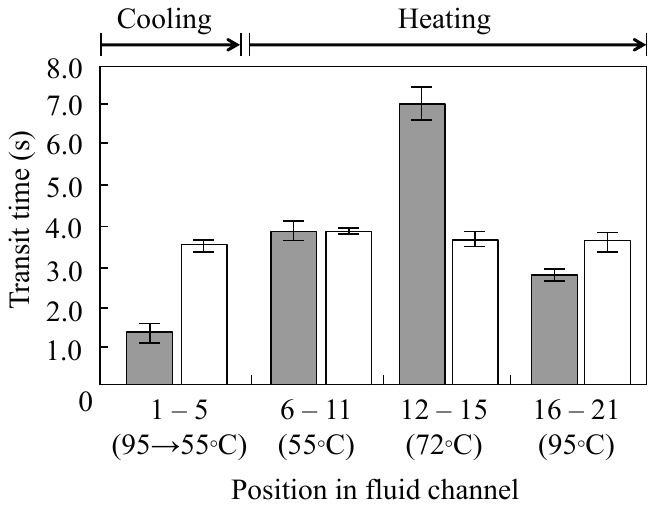
Figure 5. Transit time in each temperature zone. Thermal cycle was performed in 15 s per cycle. The gray and white bars show the transit time of plug flow and continuous flow, respectively. All measurements were taken three times for each position in fluid